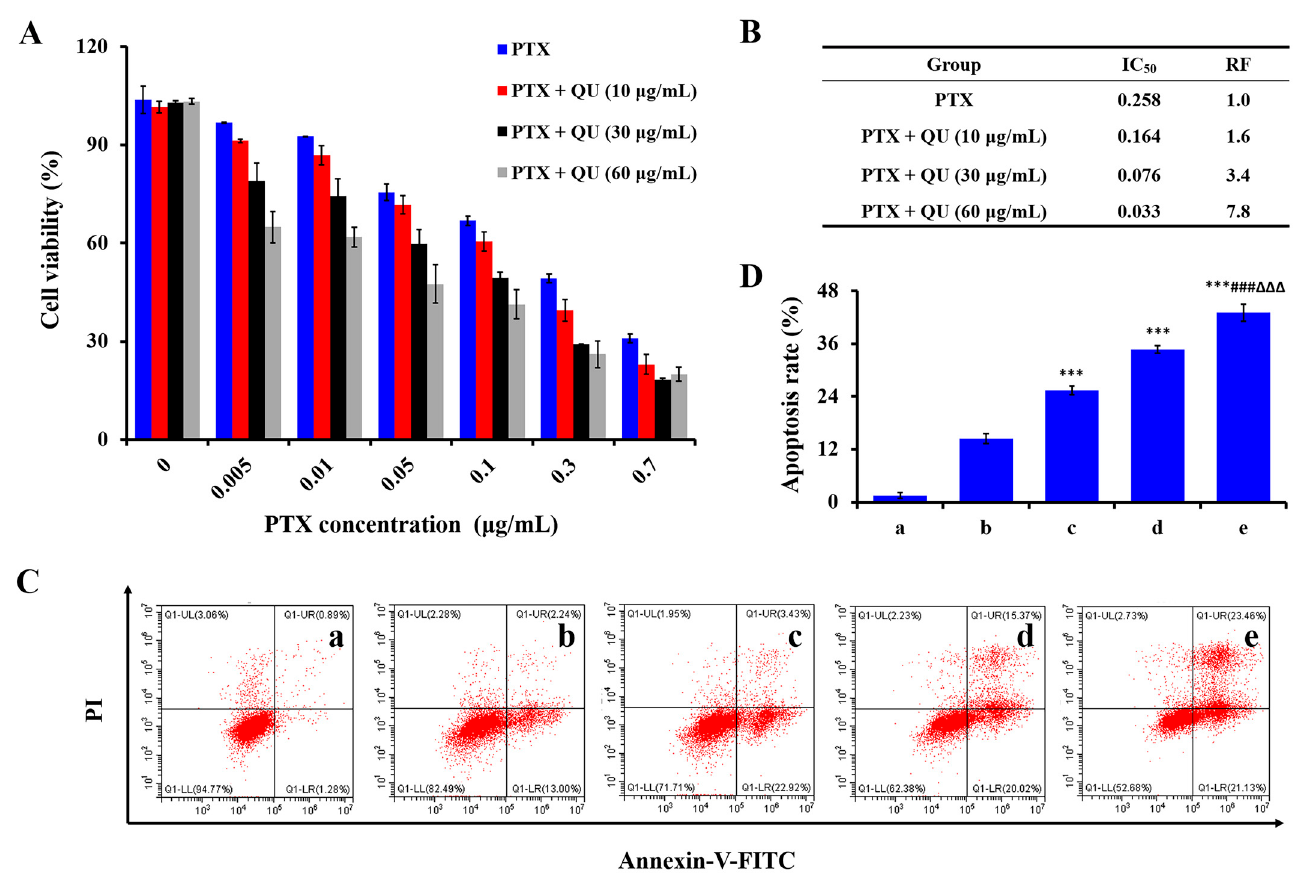
Figure 1. The synergetic cytotoxic effect of PTX and QU. ( A ) The viability of MCF-7/ADR breast cancer cells after treatment with PTX alone or in combination with increasing concentrations of QU for 72 h. ( B ) The summarized table of IC 50 ( μ g/mL) and RF values. ( C ) Flow cytometric analysis of cell apoptosis after treatment with ( a ) DMEM, ( b – e ) free PTX at 0.3 μ g/mL in combination with QU at different concentrations (0, 10, 30, and 60 μ g/mL) for 72 h. ( D ) Quantitative analysis of the total apoptosis rate. Statistical significance: *** p < 0.005 compared with the b group, ### p < 0.005 compared with the c group, ∆∆∆ p < 0.005 compared with the d group. Data are presented as the mean values ± SD ( n = 3).